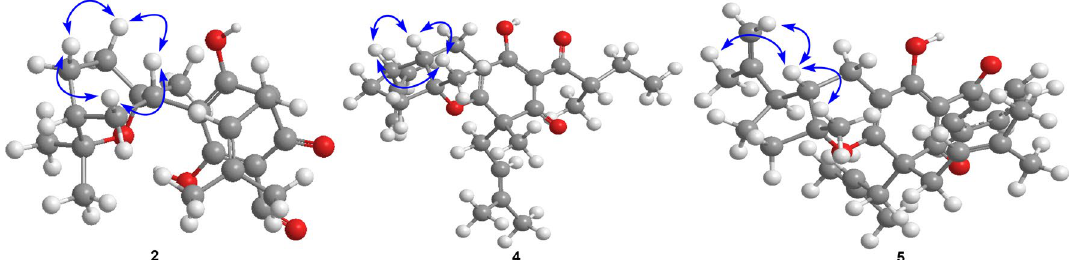
Fig. 5 Key ROESY correlations of 2 , 4 and